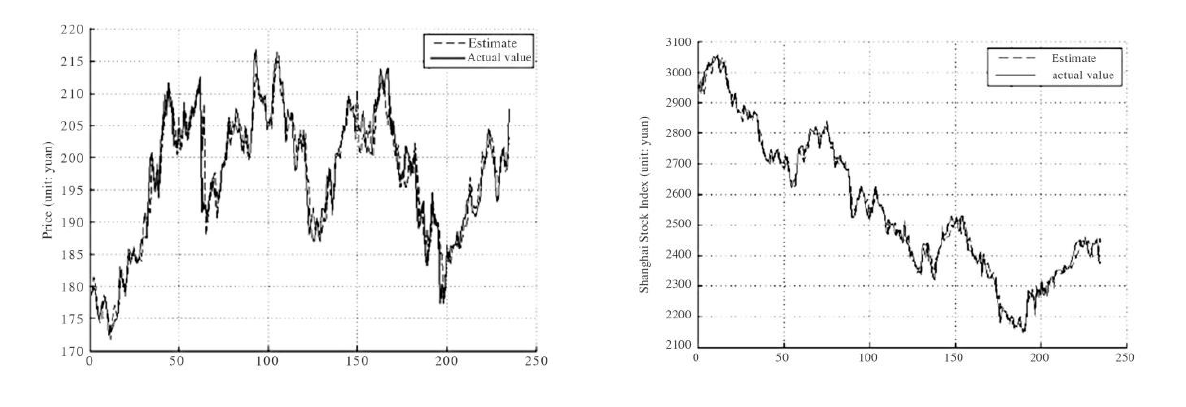
Fig. 4 Comparison curve between predicted SPPM value and actual